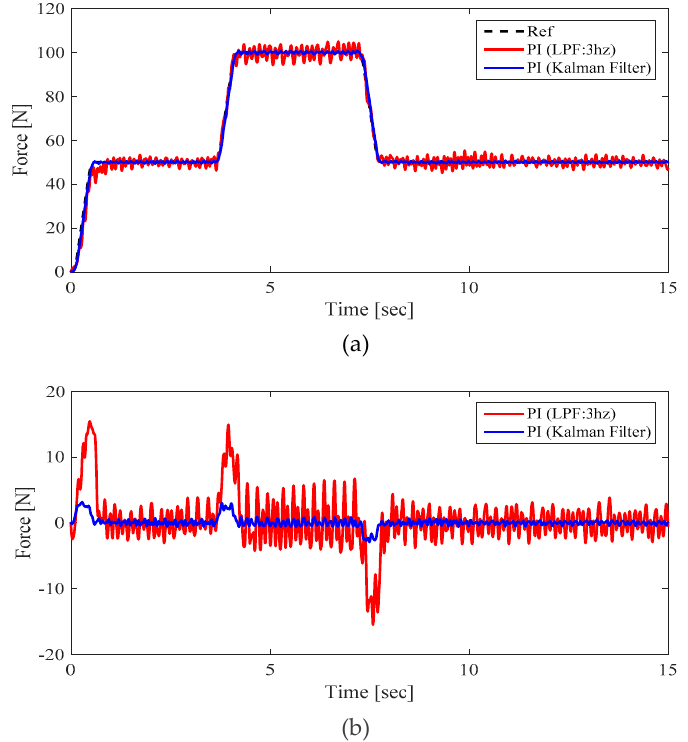
Figure 10. Experimental results to verify the effectiveness of KF: ( a ) Reference and measured tension; ( b ) Tracking errors.